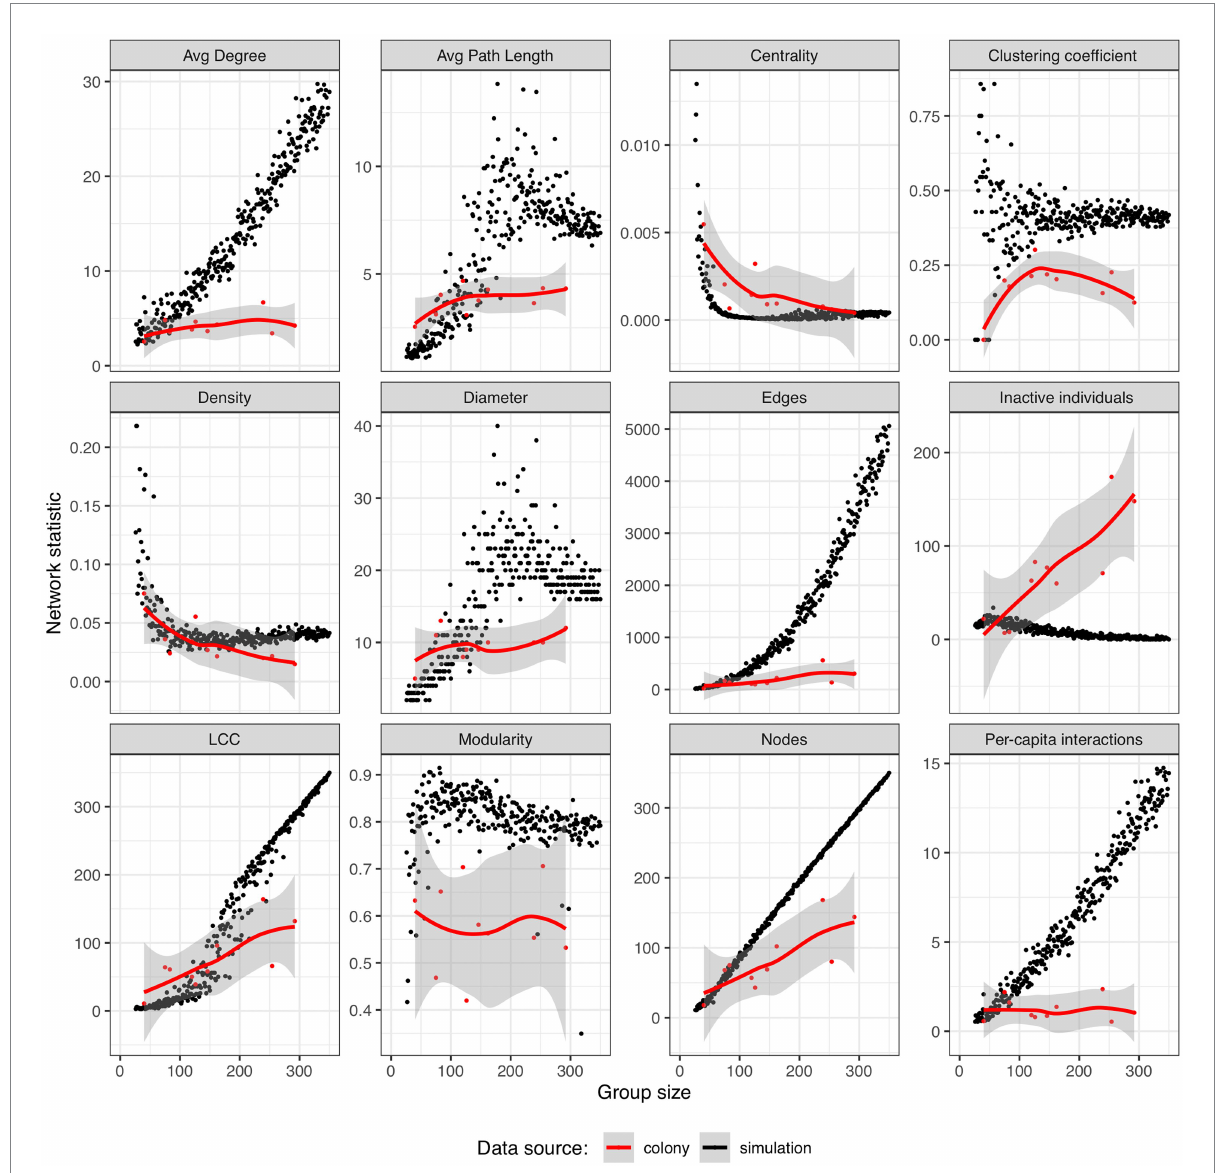
FIGURE 3 Comparing the scaling of antennation-based ant colony social network structure with the predictions of the spatially explicit random interaction simulation. Simulation results are plotted as black dots and P. californicus data are represented as red dots and additionally plotted with a loess smoothing curve in red and its associated error as a shaded region. Data are plotted for 324 simulated networks ranging in size from 25 to 357 individuals and in the number of nodes from 11 to